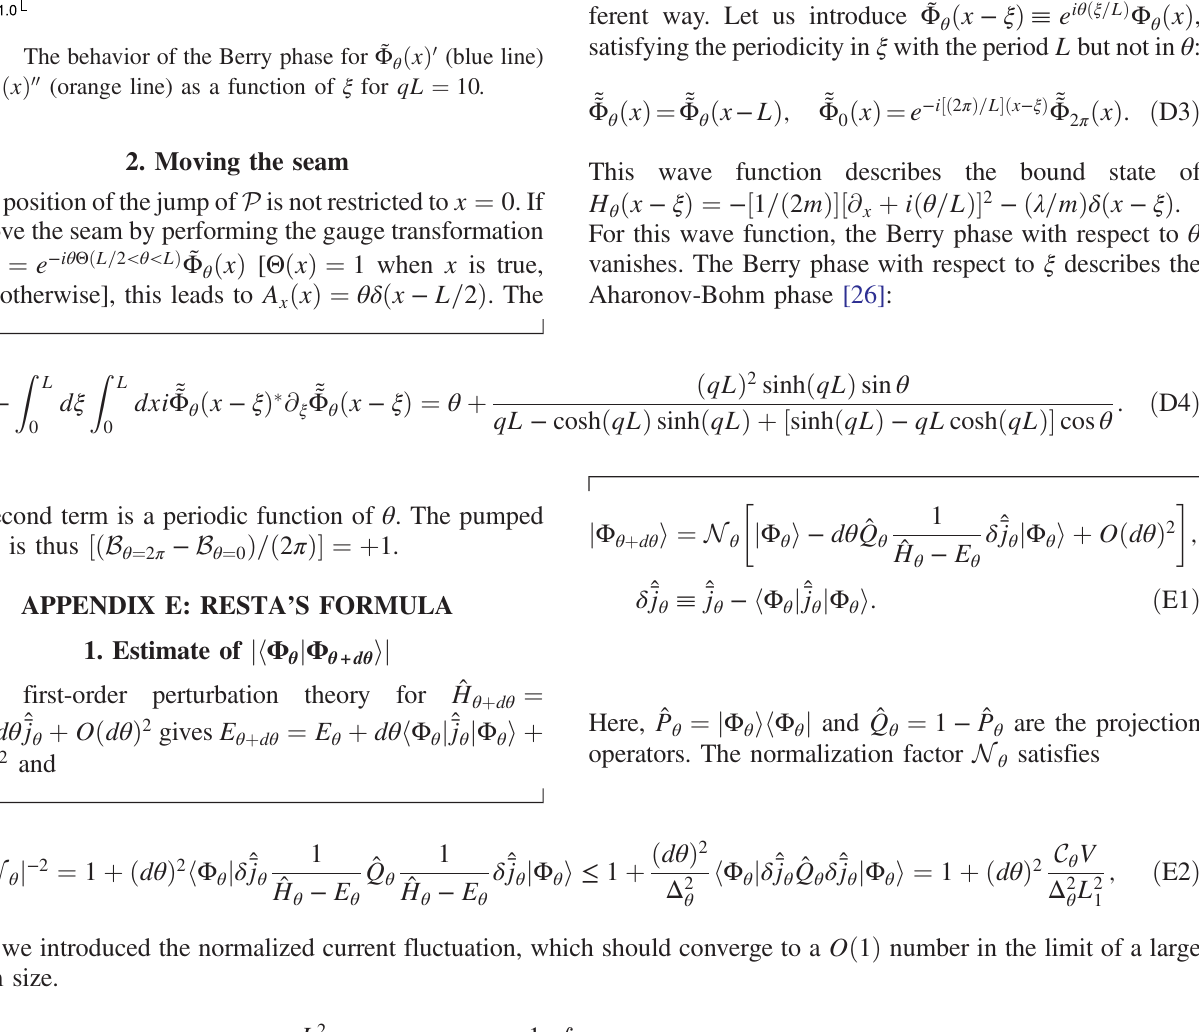
˜ Φ x Þ 0 (blue line) θ ð